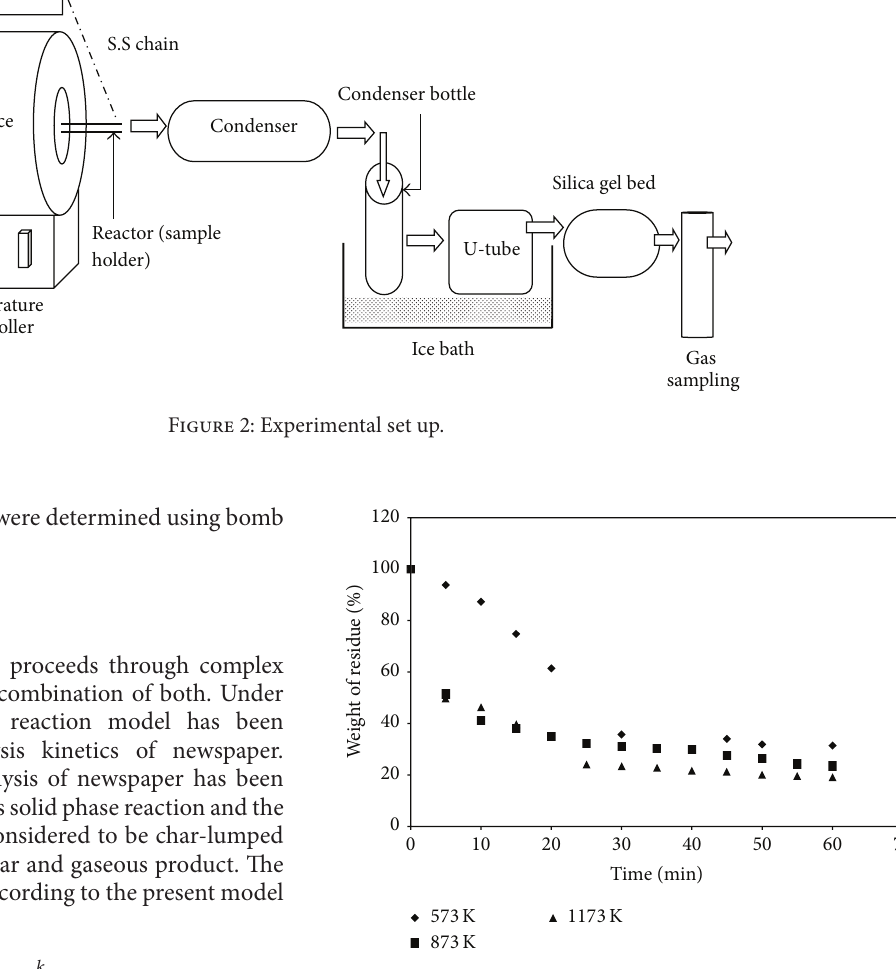
Figure 3: Variation of percentage of weight of residue of newspaper sample with respect to time at different pyrolysis